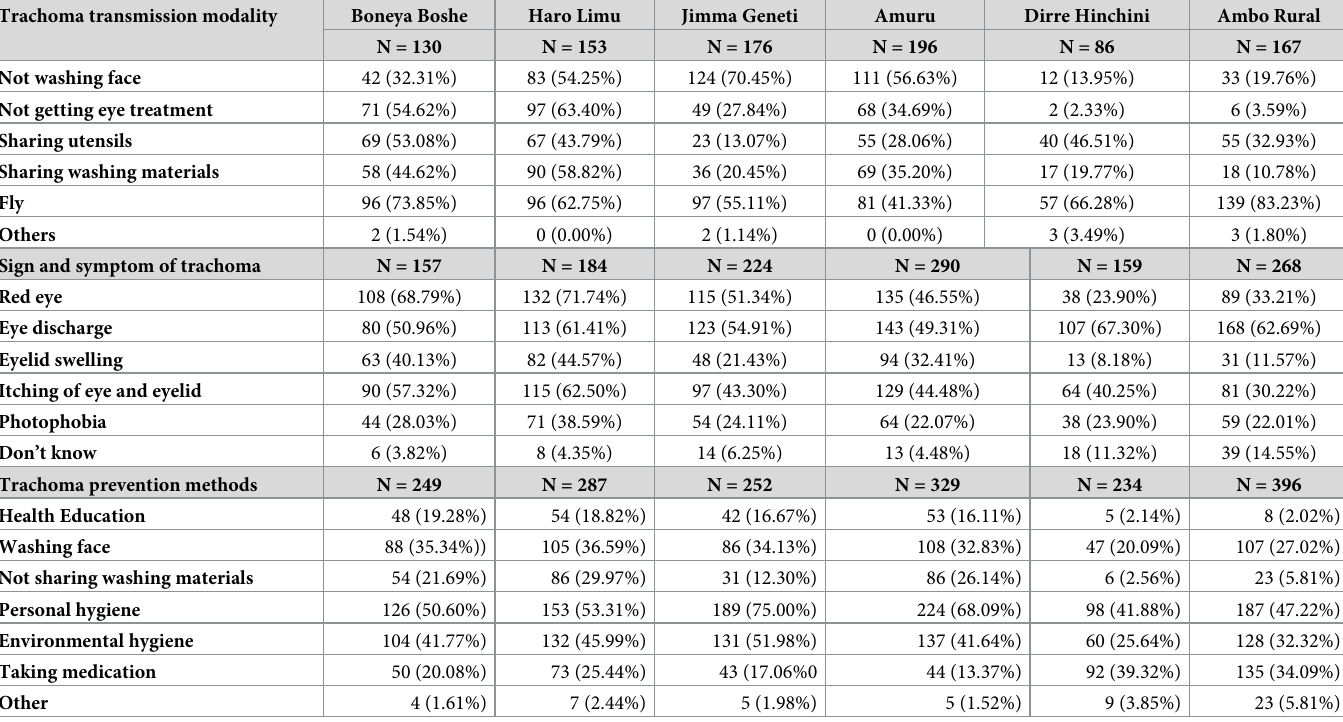
Table 4. Respondents awareness regarding trachoma among six districts of East Wollega, Horo Guduru Wollega and West Shewa zones survey population, 2017.